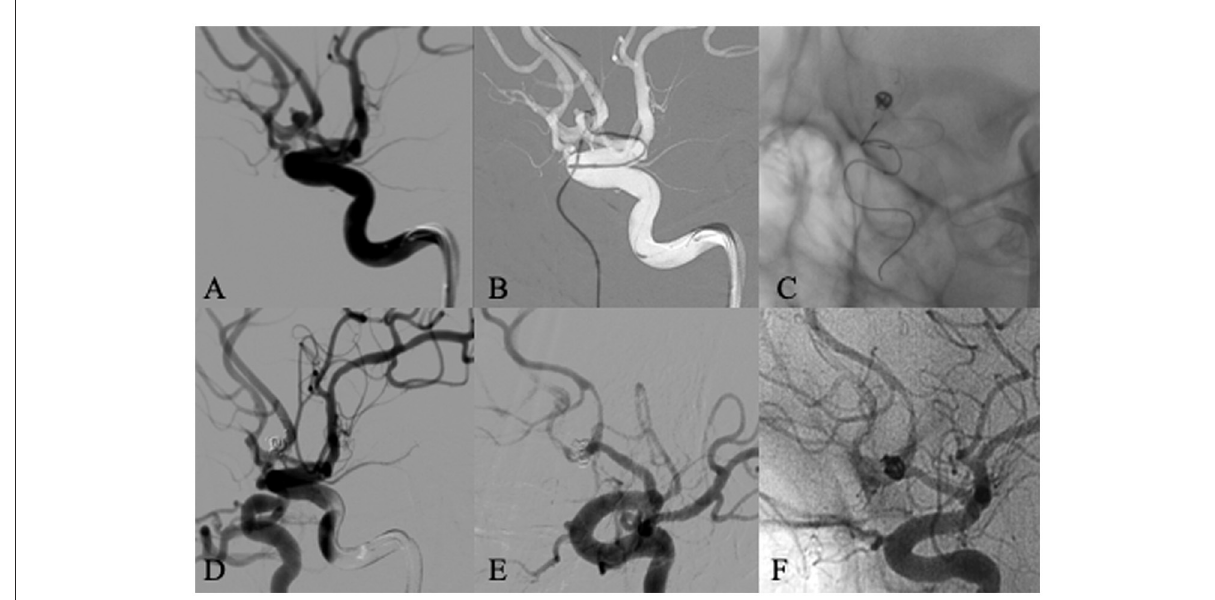
FIGURE3 A 59 years old male patient presented with subarachnoid hemorrhage. Left ICA angiogram showed an anterior communicating aneurysm with a daughter sac and a wide neck incorporating both A1/A2 junctions (A) . The aneurysm was selected with a microcatheter for embolization from left A1, and a Leo baby stent was deployed from right A1 to left A2, crossing anterior communicating artery and covering the neck of the aneurysm (B,C) . The immediate angiogram after embolization showed complete occlusion of the aneurysm and patent anterior cerebral artery (D) . Follow-up angiography 6 months later showed in-stent stenosis without any symptom (E,F)